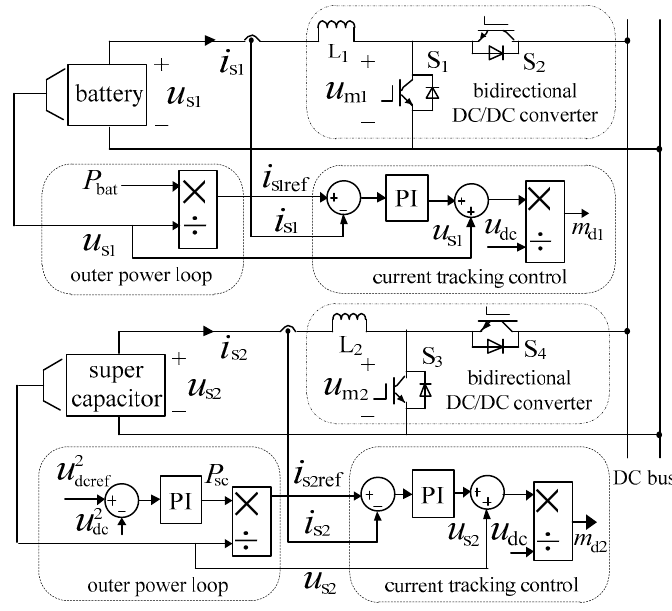
Figure 6. Charging and discharging control of the self-energy storage system.